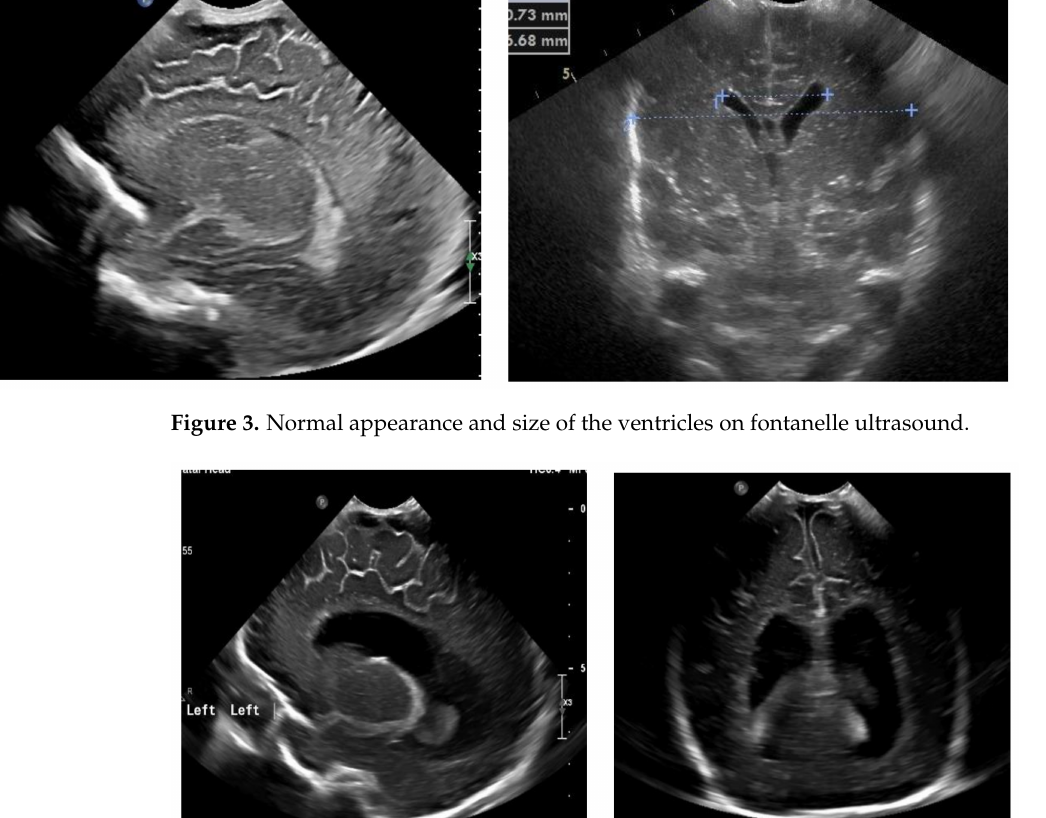
Figure 4. Ventriculomegaly, which requires V-P shunting on fontanelle